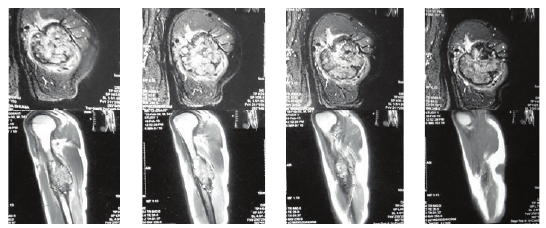
Figure 5: MRI of left upper extremity showing osteolytic lesion in left humerus with marrow edema and soft tissue